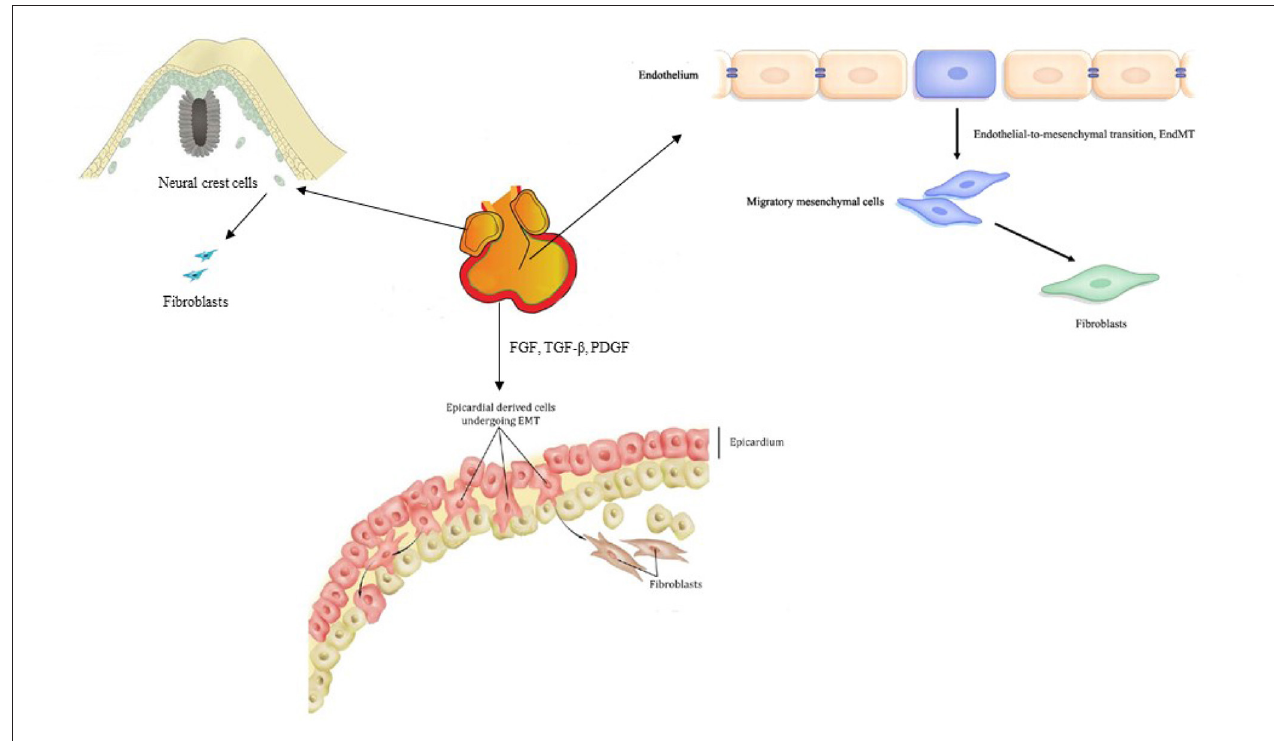
FIGURE 2 | Origin of cardiac fibroblasts.